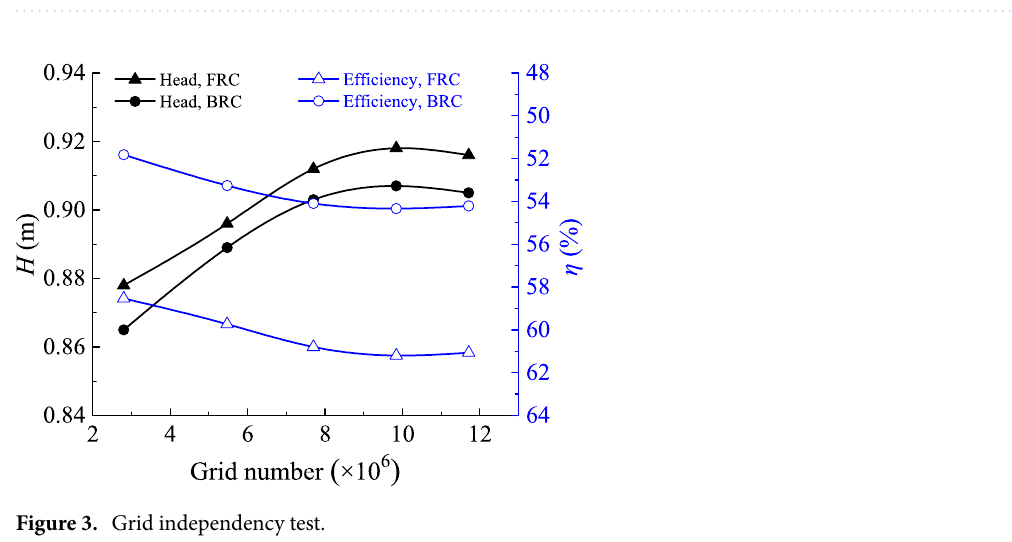
Table 3. Parameter values of different numerical simulation schemes.